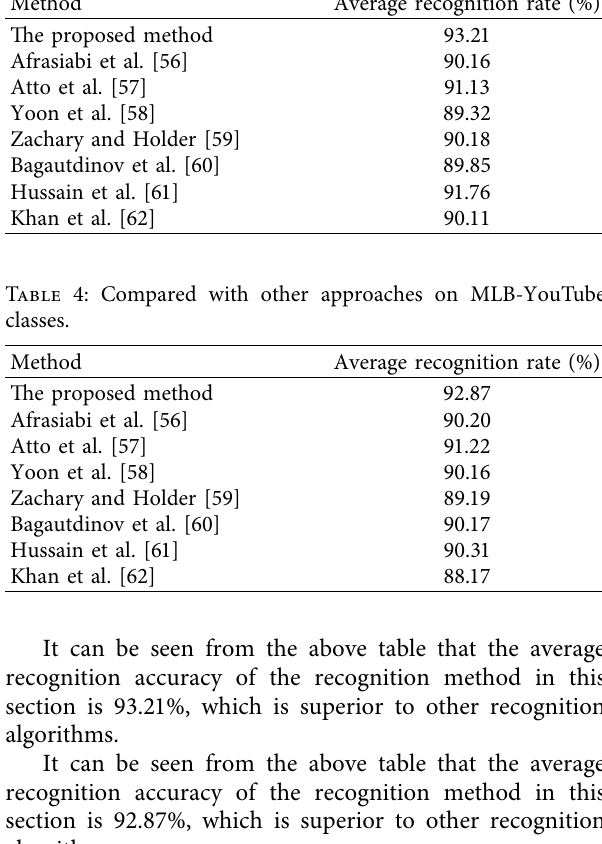
Table 7: Compared with other approaches on the Vlog dataset and AVA dataset (strong occlusion and high dynamic video).